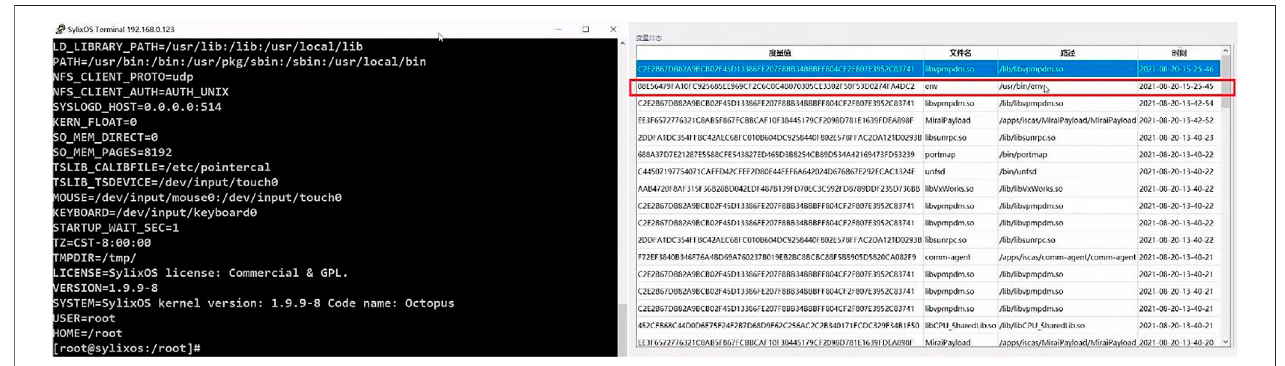
FIGURE 8 | Measurement value of the env program and the library fi le libvpmpdm.so.